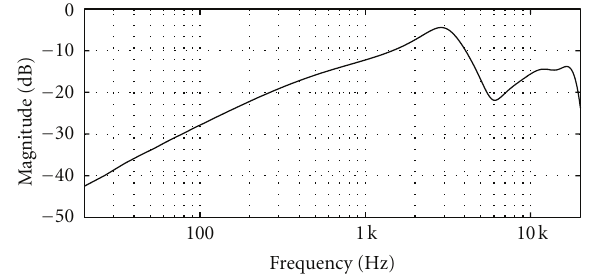
Figure 4: Transfer functions from an external sound source to an ear canal: black curve depicts an open ear case and gray curve is measured when the sound travels through an unequalized ARA headset into the ear canal. Modified from [4].